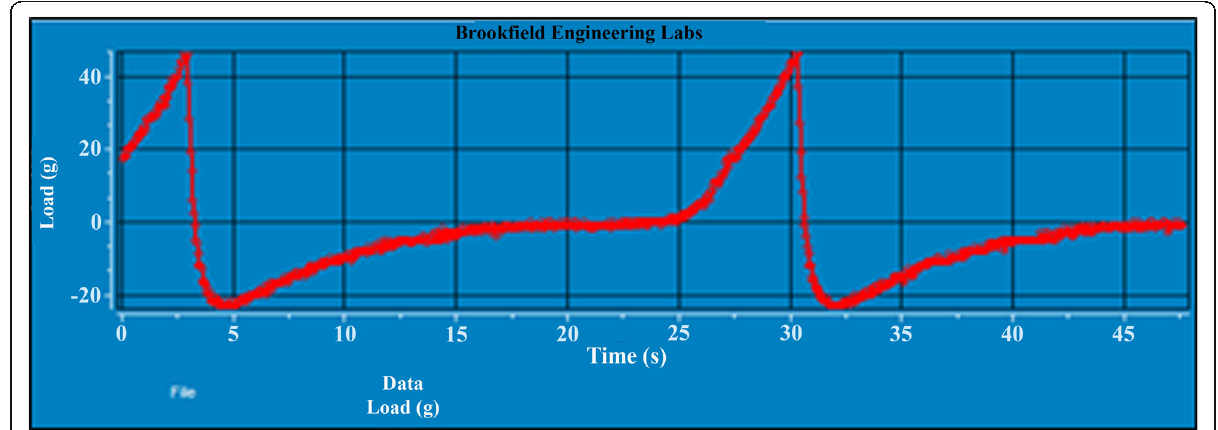
Fig. 6 Spreadability graph of microemulsion containing sunscreen